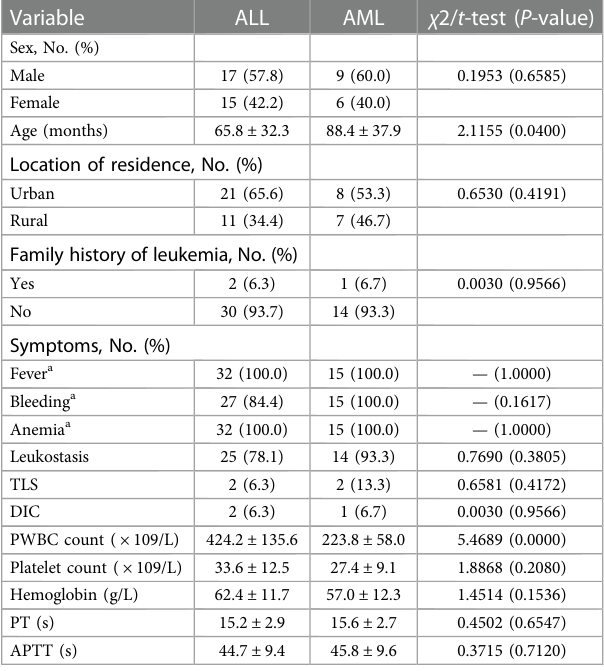
TABLE 1 Demographic and clinical characteristics of cases. Variable